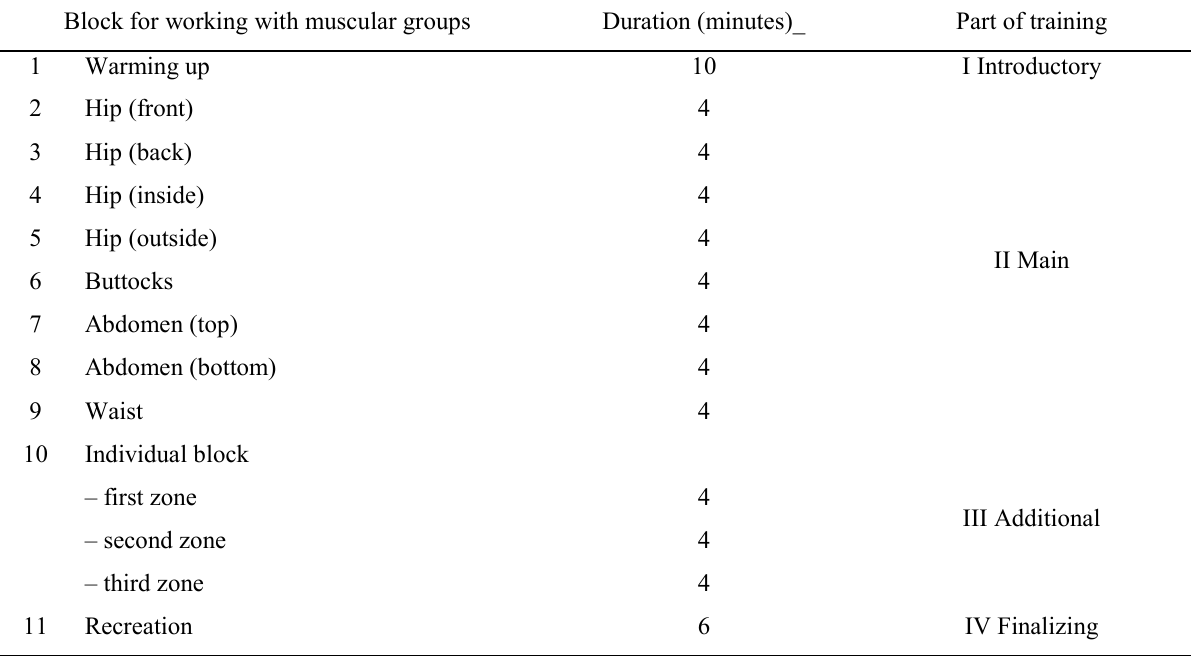
Table 1. Structure of shaping trainings in experimental group STRUCTURE OF TRAININGS Block for working with muscular